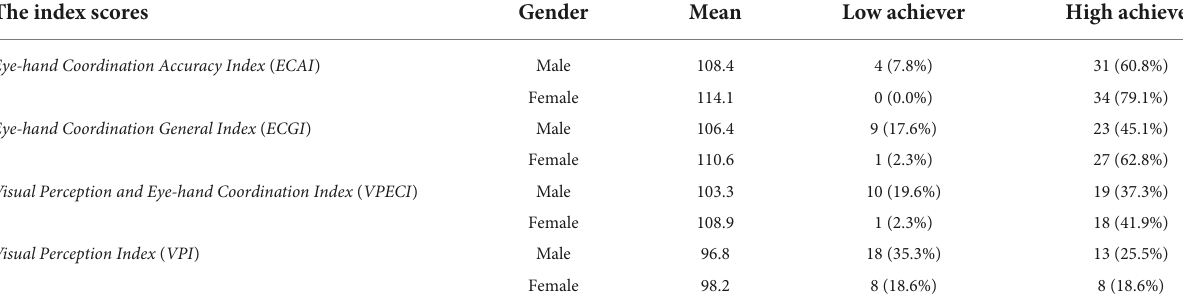
TABLE 2 Students’ WAVES index